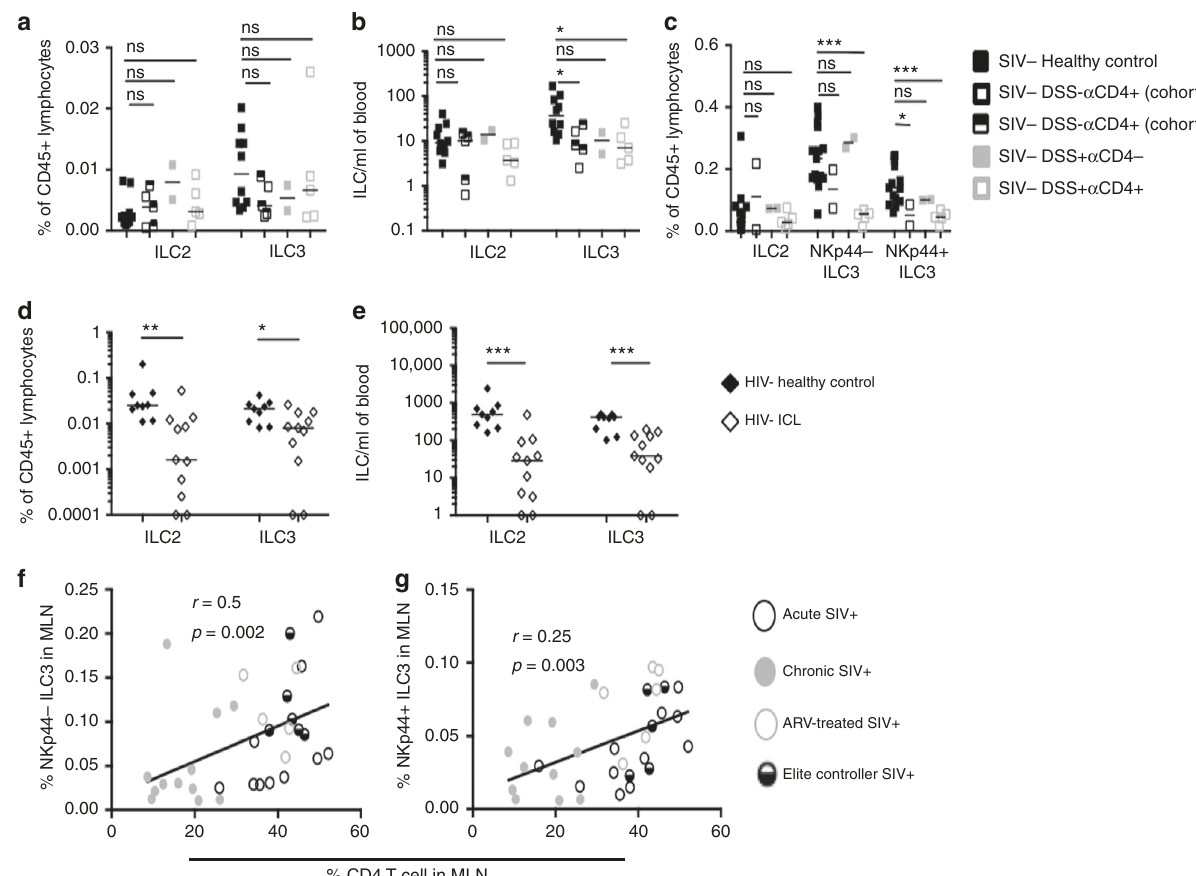
Fig. 6 De fi cient ILCs in CD4 lymphopenic HIV/SIV-uninfected human and nonhuman primates. a Frequencies and b absolute numbers of ILC subsets in blood of uninfected control animals ( N = 9), animals receiving DSS ( N = 2), or animals experimentally depleted of CD4 T cells with ( N = 5) or without DSS treatment ( N = 5). c Frequencies of ILCs in MLN of healthy control, SIV-uninfected DSS-treated, α CD4-treated, or animals receiving both treatments. d Frequencies and e absolute numbers of blood ILCs in healthy ( N = 10) and ICL ( N = 11) human subjects. Correlation between f NKp44 − ILC3 and g NKp44 + ILC3 percentages and CD4 T cell percentage in the MLN of SIV + RMs. Statistical signi fi cance was calculated using the Mann – Whitney test. A Pearson's correlation was calculated for panels f , g . ns = P > 0.05, * = P ≤ 0.05, ** = P ≤ 0.01, *** = P ≤ 0.001, and **** = P ≤